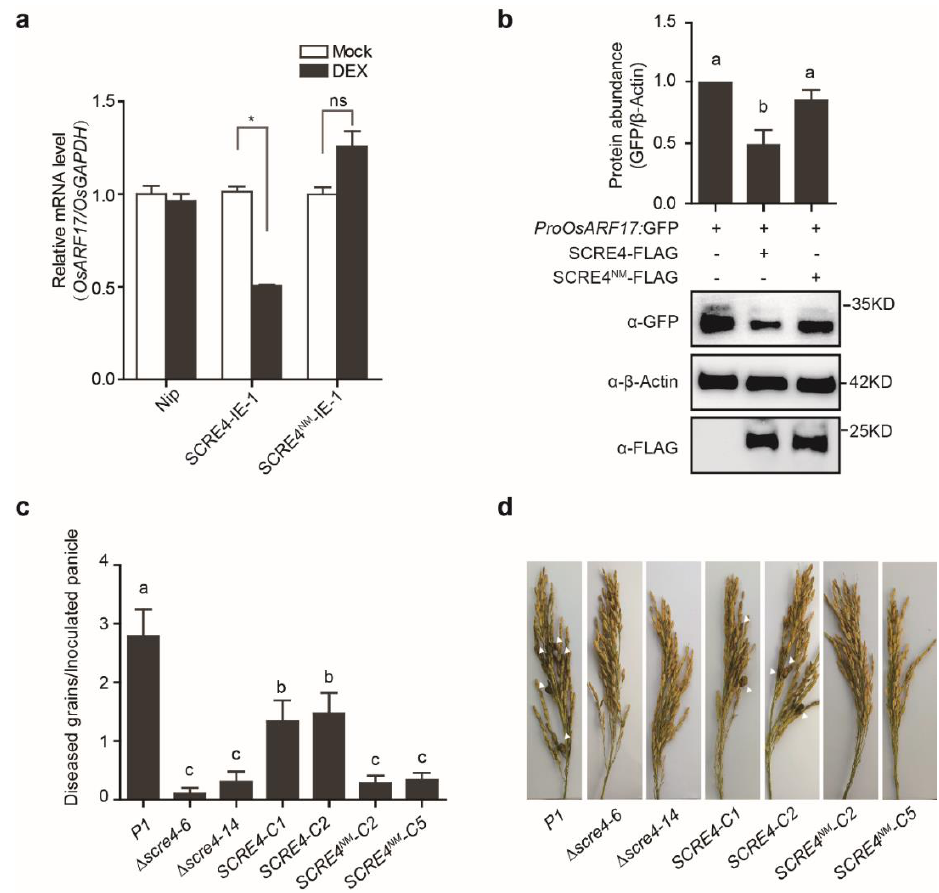
Figure 6. The ability of SCRE4 to suppress rice immunity is dependent on nuclear localization. ( a ) Expression of OsARF17 in the wild − type, SCRE4 − IE and SCRE4 NM − IE transgenic lines after DEX and mock treatments. OsGAPDH expression was used as an internal reference. Asterisk indicates signif- icant difference in the expression level of OsARF17 in the SCRE4 − IE − 1 line between DEX and mock treatments (Student’s t -test, * p < 0.05). ( b ) The GFP expression level driven by the OsARF17 pro- moter when the ProOsARF17: GFP construct was co-transfected with the SCRE4 or SCRE4 NM con- structs into rice protoplasts. Total proteins were subject to Western blot analyses probed with anti − GFP, anti −β− Actin and anti − FLAG antibodies. Upper panel, the band intensity was quantified with Image J. Data from three independent assays are shown as mean ± SE ( n = 4). Different letters (a vs. b) indicate a significant difference in relative GFP abundance between SCRE4 − and SCRE4 NM −expressing protoplasts (Duncan’s multiple range test, p < 0.05). ( c ) Diseased grains on rice panicles after inoculation of different U. virens strains. The U. virens wild − type (P1), scre4 knockout mutant and complemented strains ( SCRE4 − C1 and C2 , SCRE4 NM − C2 and C5 ) were injection-inocu- lated into young panicles of the susceptible rice cultivar LYP9 ( n = 14, 10, 13, 15, 15, 14, 15). ( d ) Disease symptoms on the representative rice panicles after U. virens inoculation. The images were captured 4 weeks after rice panicles of LYP9 were inoculated by the wild − type (P1), different scre4 knockout and complemented strains ( SCRE4 − C1 and C2 , SCRE4 NM − C2 and C5 ). False smut balls are indicated by white triangles.